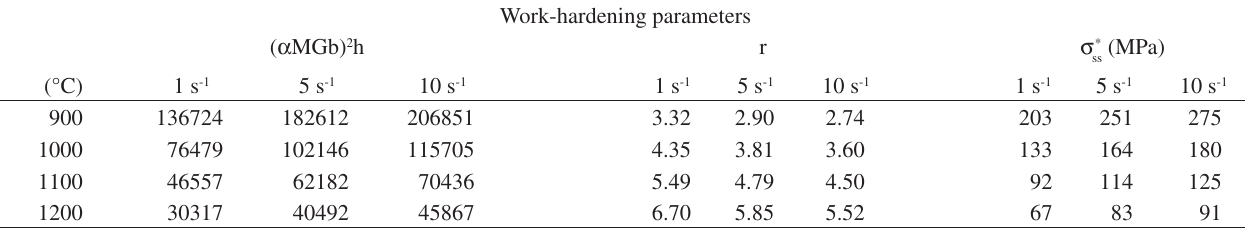
Table 3. Dependence of the work-hardening parameters on deformation conditions.